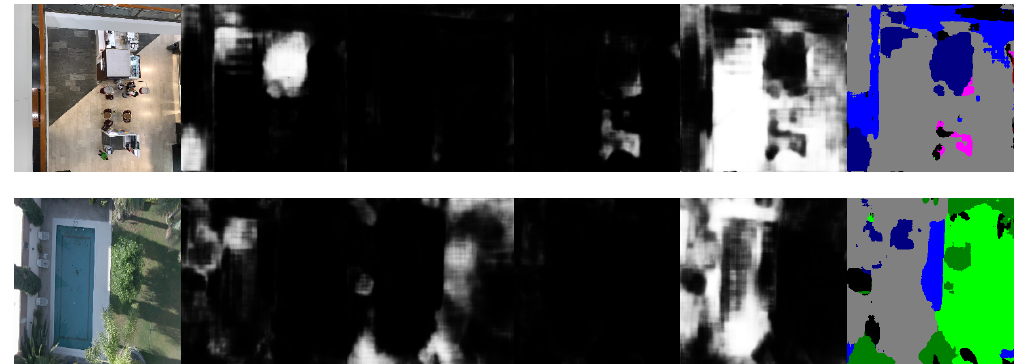
Figure 15. Results on the test, first column the input image. The second column shows the output layer corresponding to the car class. In the third column the output layer for the tree class. The fourth column contains the pixels classified with the person label. Fifth column shows the output for the cement class and, finally, the output with all of the classes presented in the